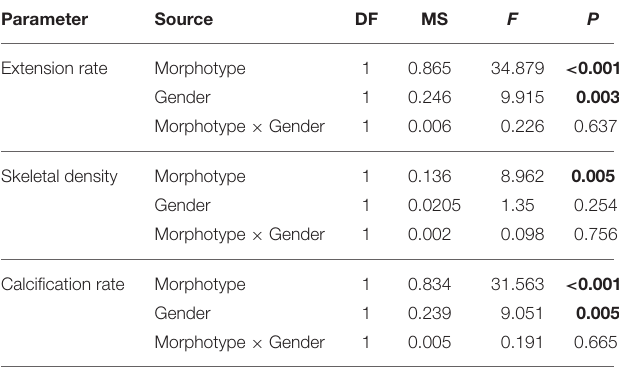
TABLE 3 | The results of two-way ANOVA’s of Porites lobata in three coral growth parameters and the interaction of the gender using both columnar and corallith